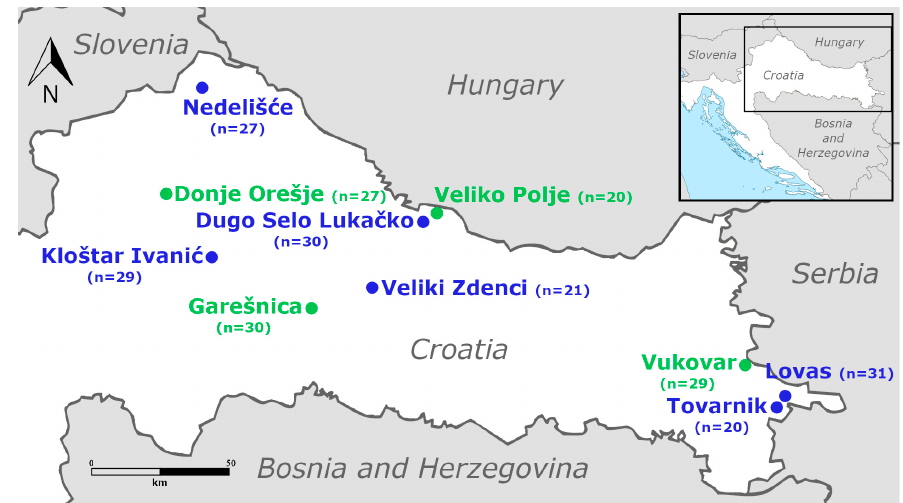
Figure 1. Sampling sites of codling moth in Croatian orchards (blue: integrated pest management (IPM) orchard, green: ecological orchard; n = number of individuals per location).